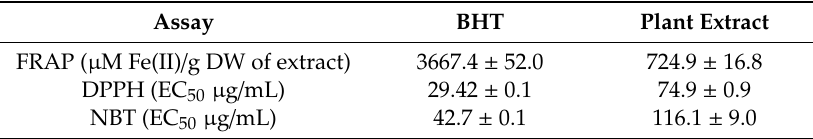
Table 3. Antioxidant capacity of hydromethanolic extract from transformed shoots of D. forrestii grown for 3 weeks in nutrient sprinkle bioreactor (NSB) in MS medium with BPA 0.5 mg / L and IAA 0.2 mg / L. Assay BHT Plant